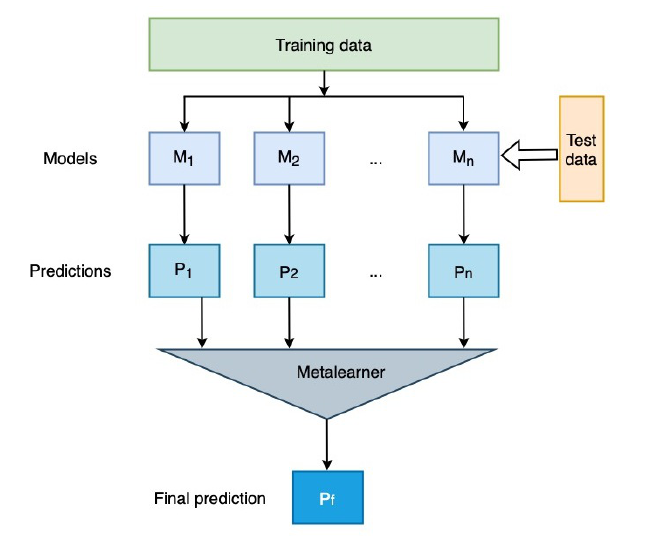
Figure 7. Stacked